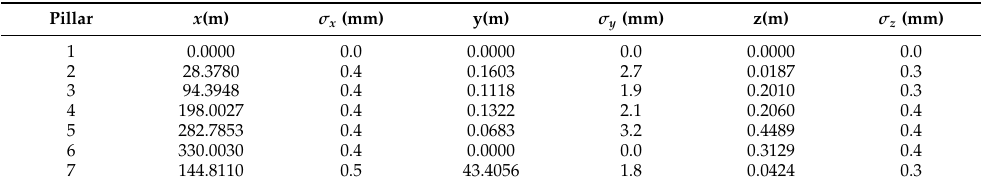
Table 1. Set of approximate 3D local coordinates (2008) and their standard deviations. The third coordinate z refers to the height at the top of the pillar relative to the top of pillar 1.